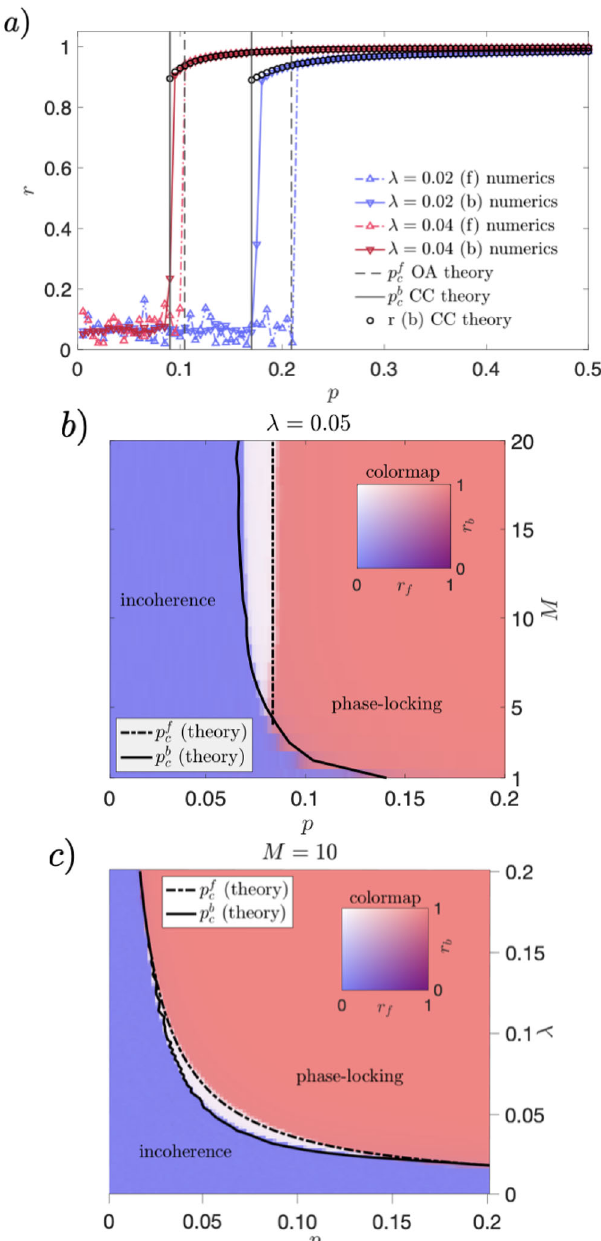
Fig. 3 Analytical characterization of the Kuramoto bomb. a Two examples of synchronization curves, r ( p ) in the forward and backward processes, for a rule dependent ( M = 10) case in a network of size N = 200 and fi xed coupling to λ = 0.02 and λ = 0.04. Measurements here are taken every 40 links and results are obtained in a single realization of the process. b Synchronization phase-space depending on M and p for a fi xed λ = 0.05. In the three panels, dashed (solid) lines correspond to the theoretical predictions of the forward (backward) synchronization thresholds, and circle markers in a give the analytical prediction of the whole backward curve (see main text and Methods section for the derivations). Note that the results displayed in Fig. 1c correspond to three M − slices here. c Synchronization phase-space depending on λ and p for a certain level of sampling M = 10. The color in the two-dimensional colormap indicates the numerical values of the tuple ( r f , r b ), and shows that the system is either in the incoherent (purple), bistable (white) or full phase-locking regime (red). Results are averaged over 20